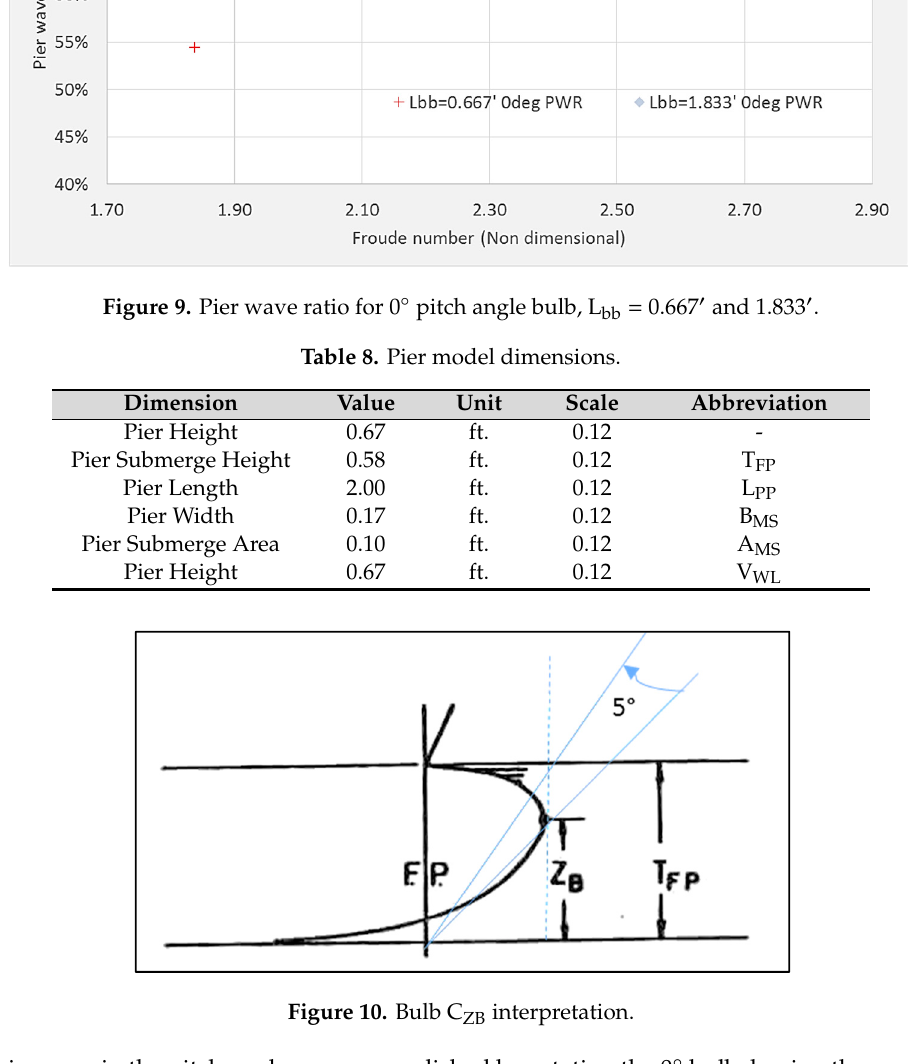
Figure 10. Bulb C ZB interpretation. Table 8. Pier model dimensions.